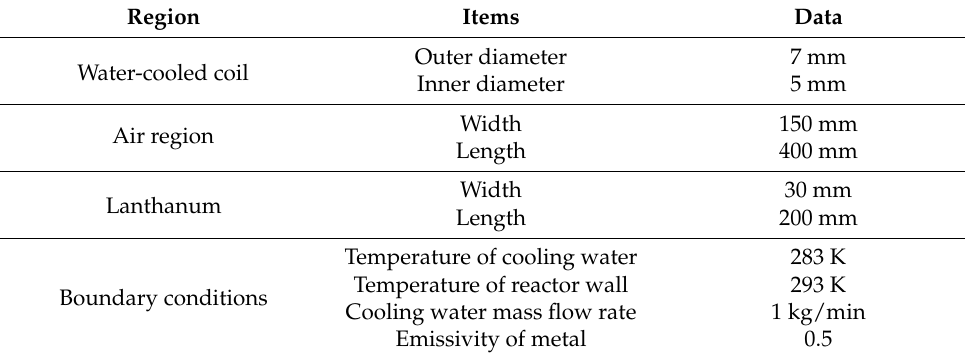
Table 1. Dimensions and boundary conditions of the zone refining